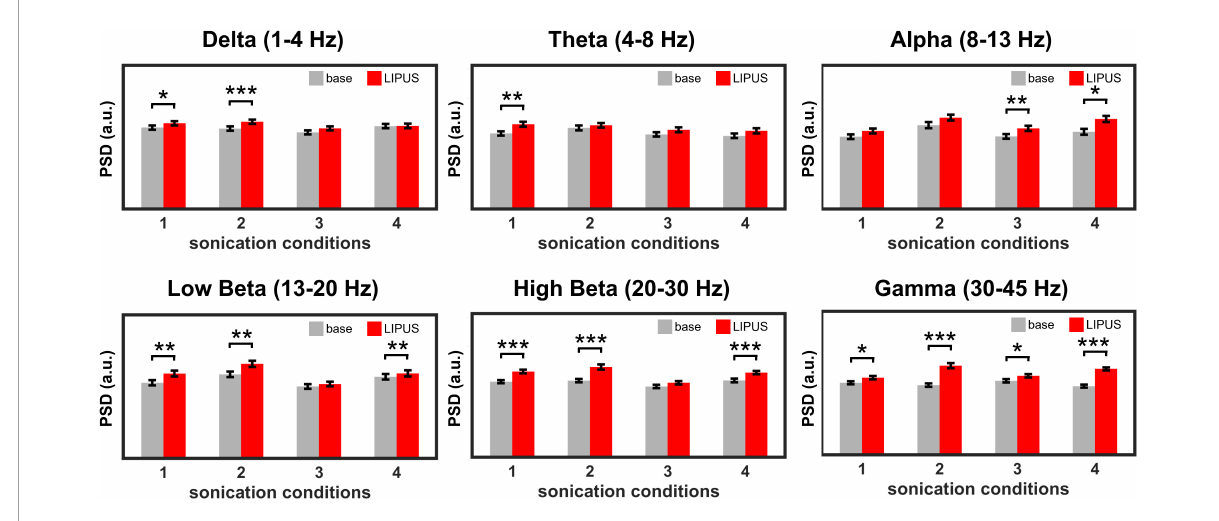
FIGURE3 Average power spectral density (PSD) obtained from the right motor cortex during baseline and LIPUS stimulation with unilateral (sonication conditions 1 and 4) and bilateral (sonication conditions 2 and 3) stimulation protocols. (* p < 0.05, ** p < 0.01, *** p < 0.001, paired t